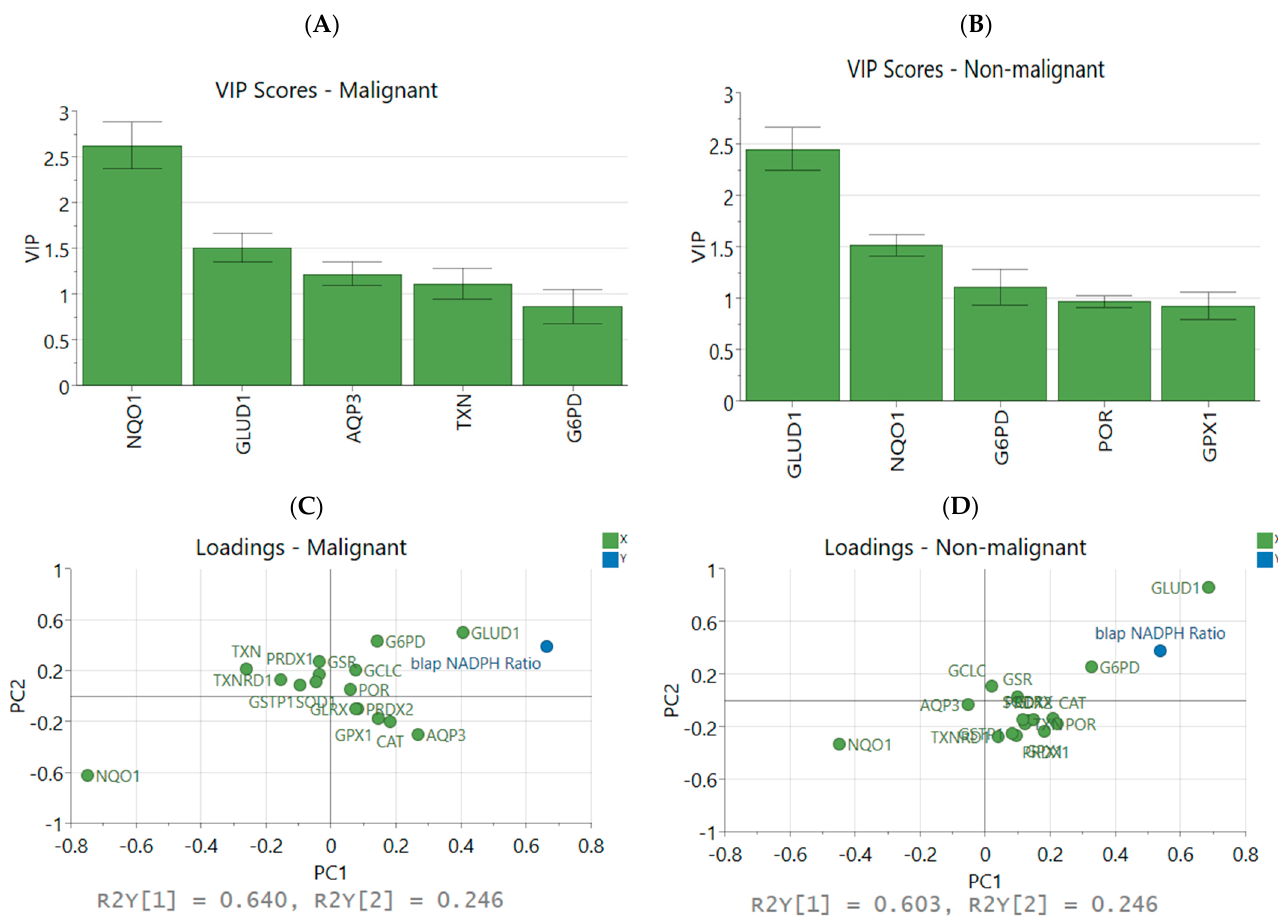
Figure 5. Partial least squares regression VIP scores and loadings. ( A ) Genes with top 5 VIP scores in the PLSR model in malignant simulations and ( B ) non-malignant simulations. ( C ) Breakdown of output into individual variables and loadings for each X and Y variable in malignant PLSR model and ( D ) non-malignant PLSR